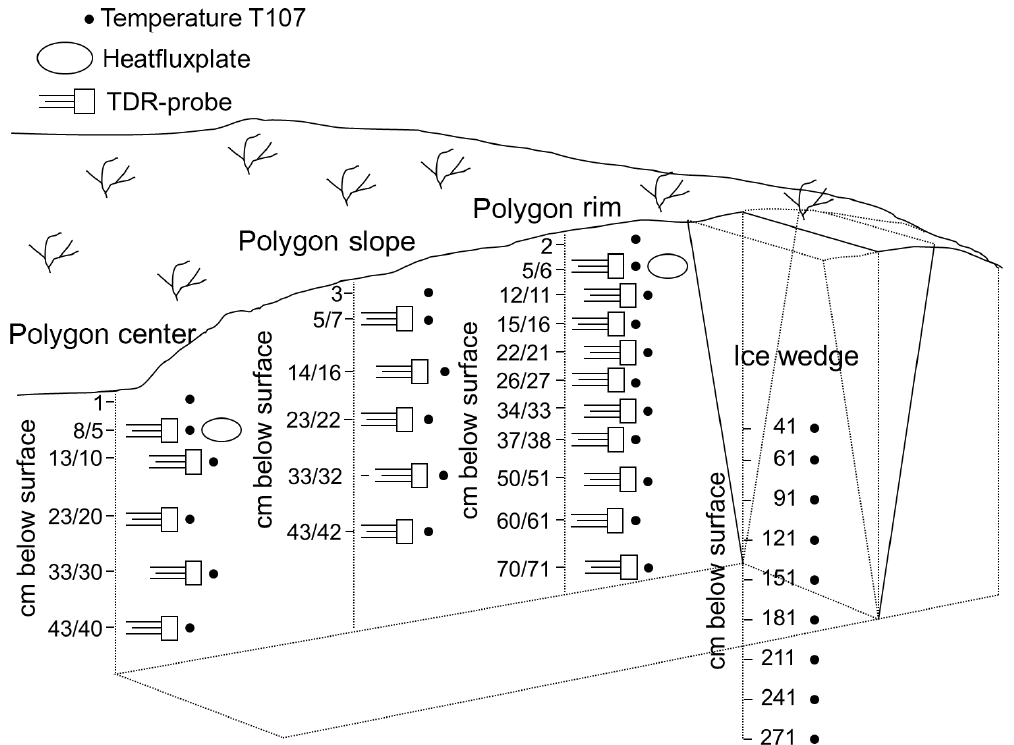
Figure B13. Diagram showing the sensor distribution below the polygon’s centre, slope, rim and inside the ice wedge, as installed on 24 August 2002. Descriptions of soil profiles and data from these profiles are provided in Appendix